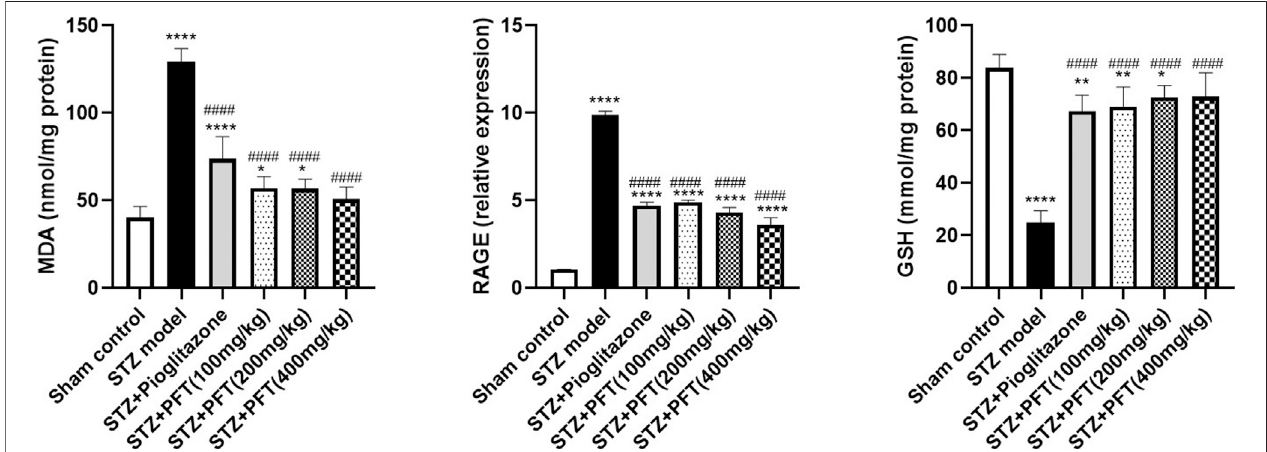
FIGURE5| PFTdiminishedSTZ-inducedoxidativestress.Eachbarwithverticallinerepresentsthemean ± SDofsixmicepergroupforMDAandGSHandofthree mice per group for RAGE; *signi fi cantly different from the sham control group at p < 0.05, ** signi fi cantly different from the sham control group at p < 0.01, **** signi fi cantly different from the sham control group at p < 0.0001, #### signi fi cantly different from the STZ group at p < 0.0001 using One-Way ANOVA followed by Tukey ’ s multiple comparisons test.